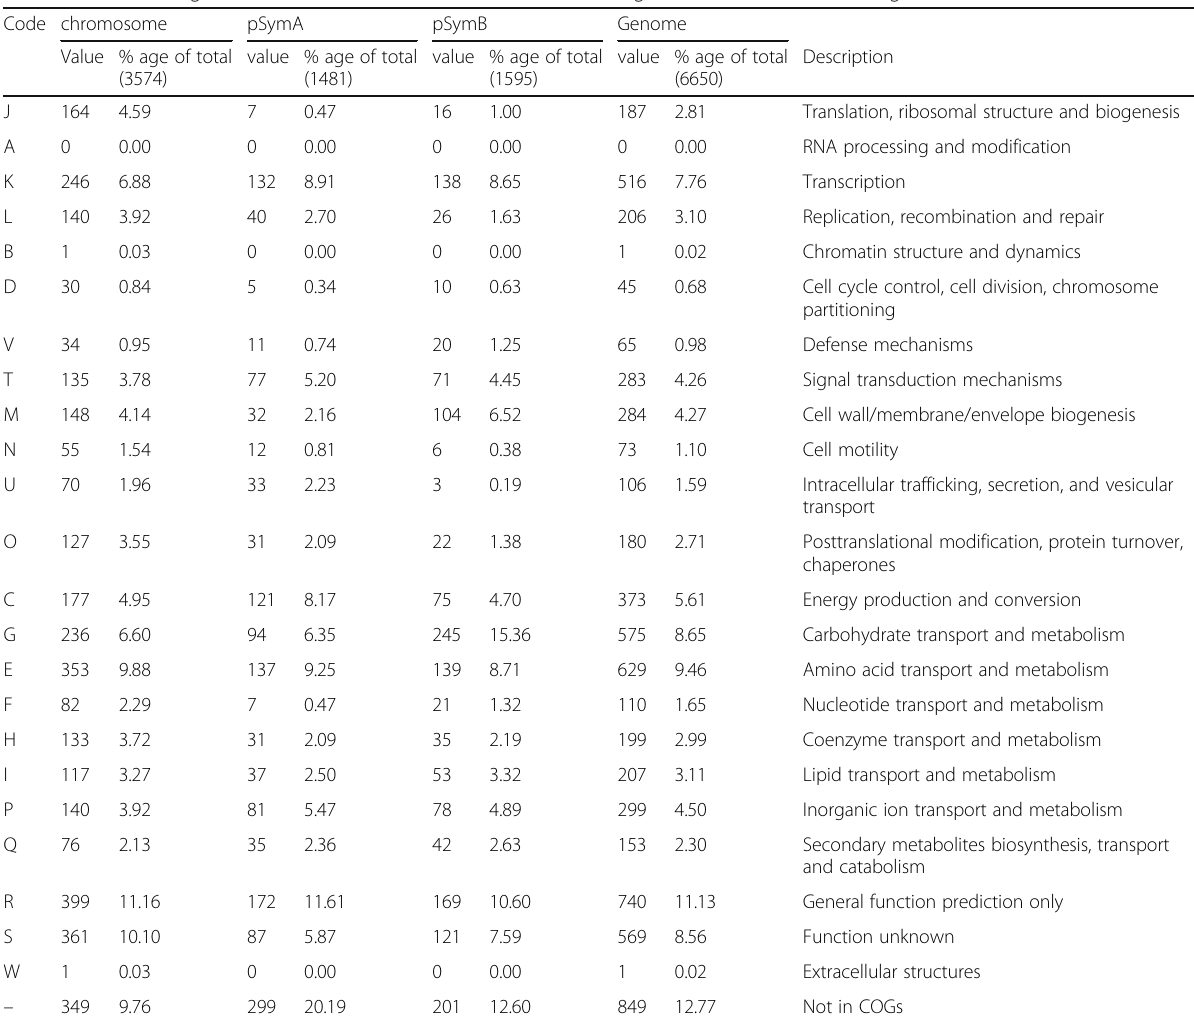
Table 5 Number of genes of Ensifer meliloti FSM-MA associated with general COG functional categories Code